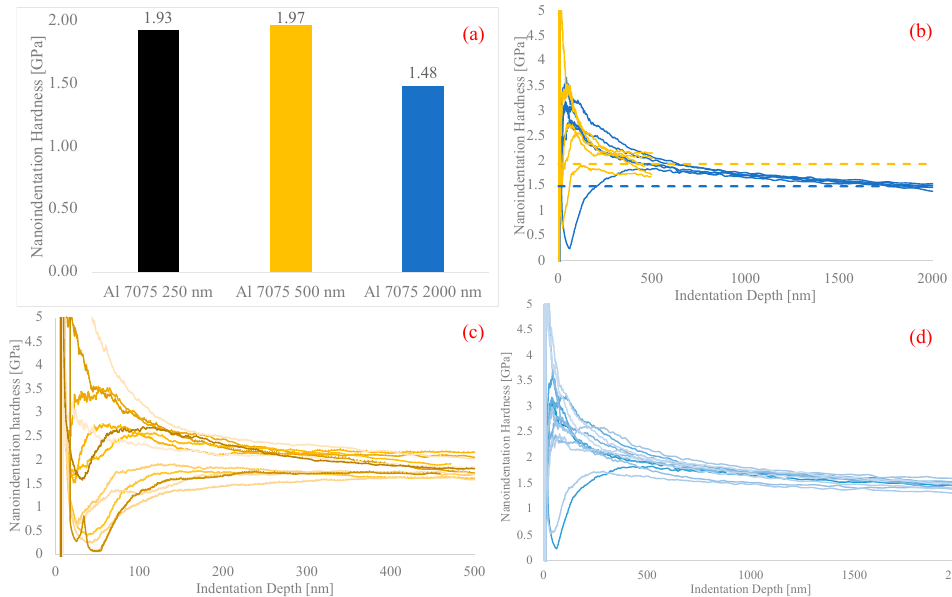
Figure 11. Illustration of the proportionality between the various hardness’s versus depth. ( a ) demonstrates the average hardness of Al 7075 gas-atomized powder particles at dynamic nanoindentation depths of 250 nm, 500 nm, and 2000 nm. ( b ) plots the data presented in ( c , d ) together in order to capture the average hardness values at 500 nm and 2000 nm, respectively. ( c ) and ( d ) plot the hardness vs. depth curves for the dynamic nanoindentation performed upon Al 7075 particles until two different maximum depths were achieved. Of course, the particle-dominated depth limit detailed in [27] was notably surpassed for ( d ) herein; thus, making the values of hardness recorded at 2000 nm as being less than the true particulate hardness. Nevertheless, it enabled the formulation of a baseline proportionality for addressing the ISE and therefore enabling direct comparisons to be made between the cast and atomized materials.